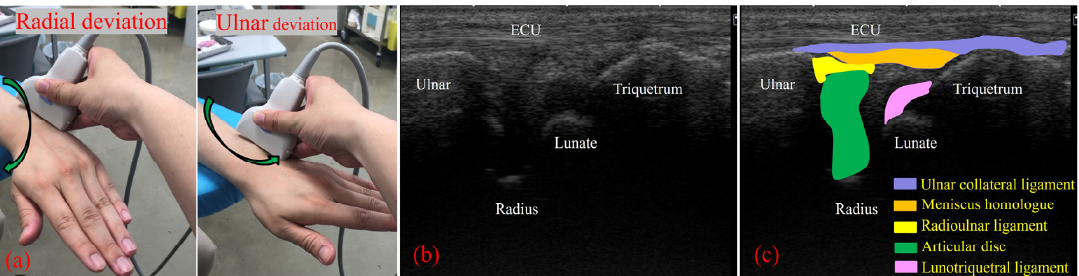
Figure 3. ( a ) Ultrasonography (US) transducer was positioned between the ulnar styloid process and the triquetrum, parallel to the extensor carpi ulnaris (ECU) tendon, with a 30 degree ulnar tilt from the vertical line. With this view, the wrist joint was moved from 15° of radial flexion to 25° of ulnar flexion. ( b ) US imaging of the TFCC by using the long-axis approach. ( c ) With this view, we can observe the ECU tendon, ulnar collateral ligament (light blue shade), meniscus homologue (orange shade), radioulnar ligament (yellow shade), articular disc (green shade), and lunotriquetral ligament (light purple shade).